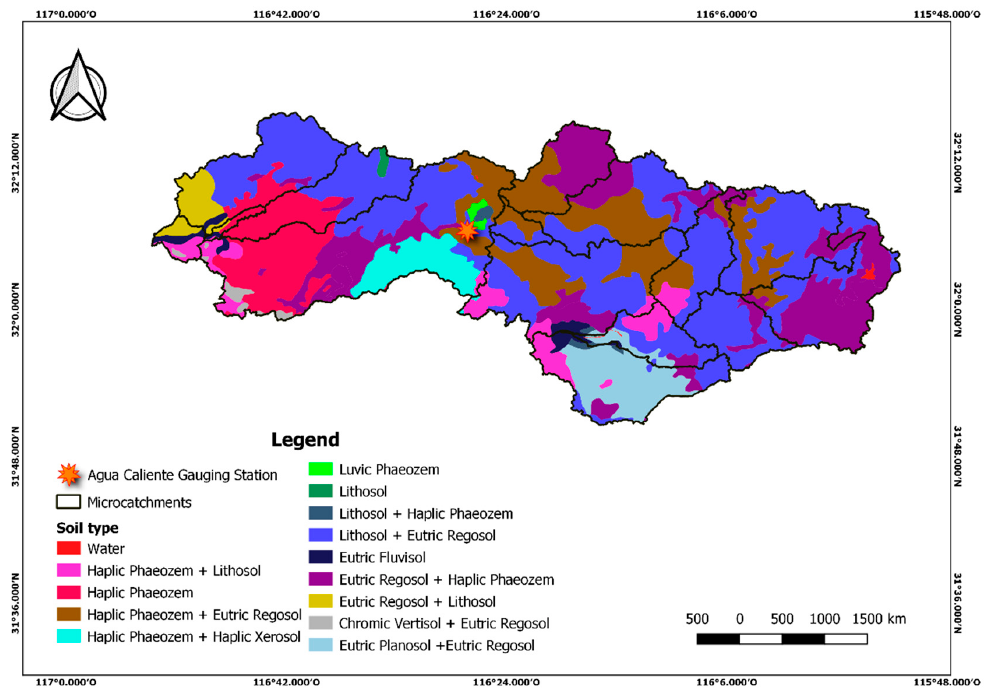
Figure 6. Soil types.